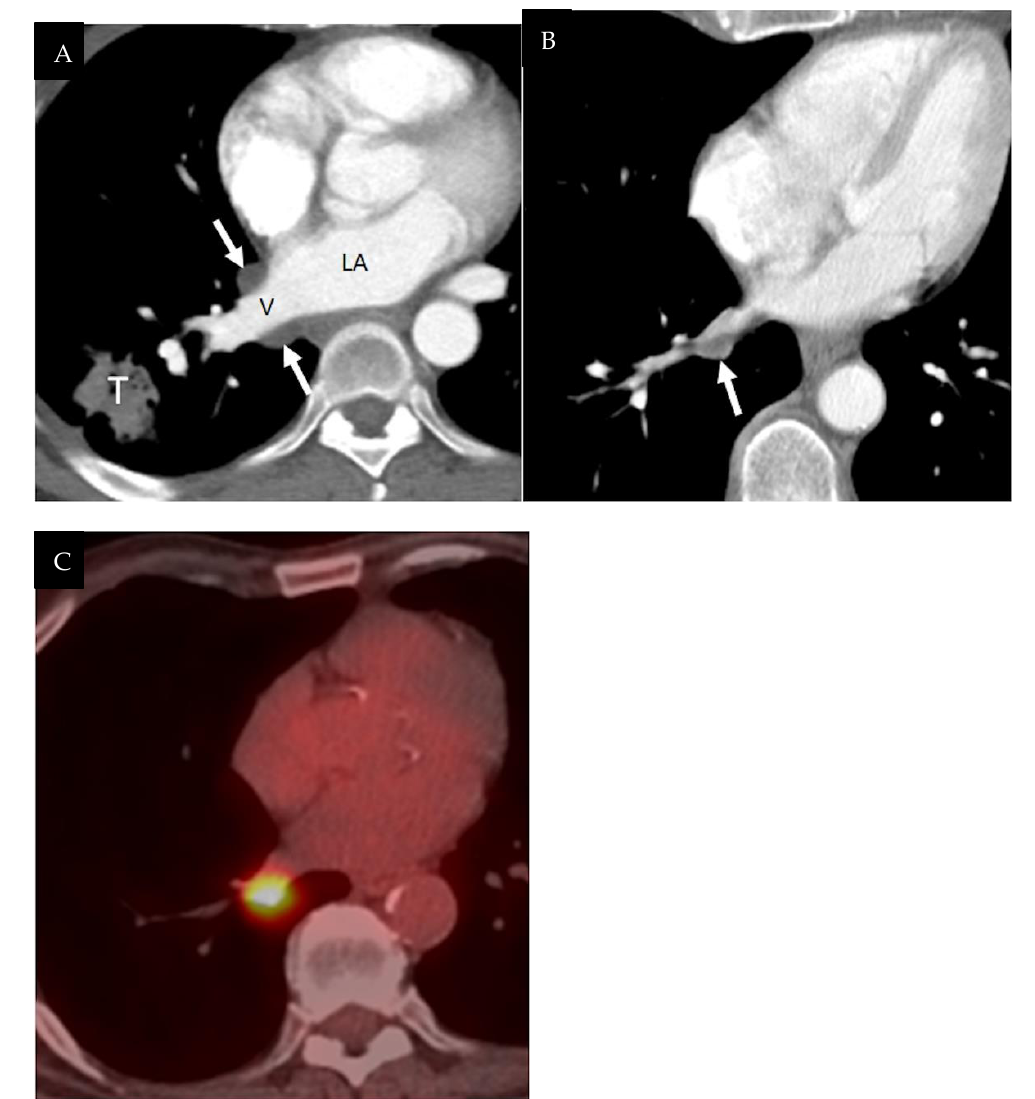
Figure 9. Fluid and adenopathy in the right pulmonary venous recess adjacent to the right inferior pulmonary vein. 57 year-old woman with right lower lobe adenocarcinoma. ( A ) Contrast-enhanced axial CT shows the right lower lobe primary tumor (T) and fluid in the right pulmonary venous recess (arrows). Typical location anterior and posterior to the vein and fluid attenuation are features that help prevent misinterpretation as adenopathy. 80 year-old man with esophageal cancer. ( B ) Contrast-enhanced axial CT shows an indeterminate low attenuation nodular opacity (arrow) posterior to the right inferior pulmonary vein that is FDG avid on PET/CT ( C ) consistent with nodal metastasis. When findings are equivocal, MRI or PET/CT can be used to distinguish adenopathy from pericardial fluid. Reprinted from Shroff, G.S et al. Pitfalls in oncologic imaging of the pericardium on CT and PET/CT [4].